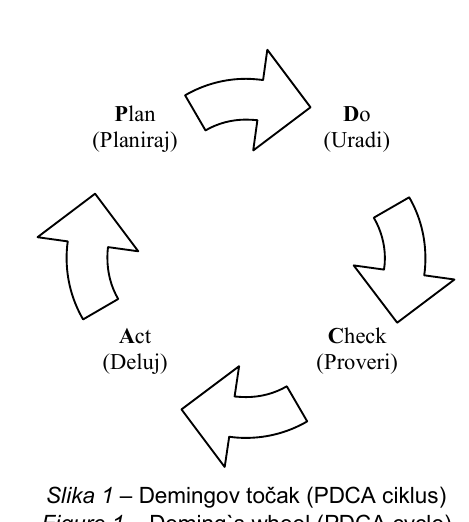
Figure 1 – Deming`s wheel (PDCA